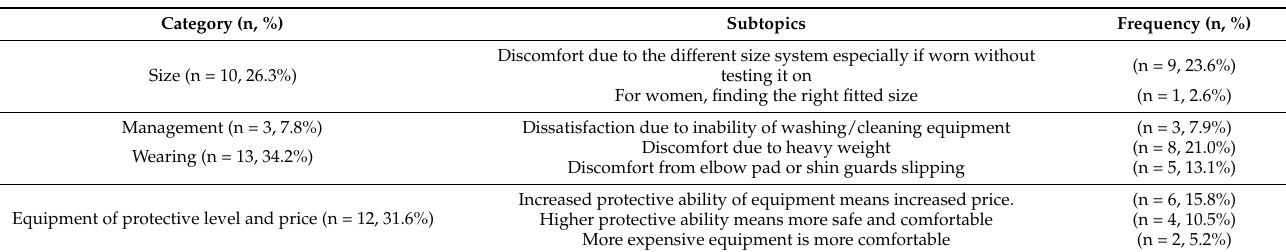
Table 6. The categories for the open-ended questions about ice hockey equipment (n =